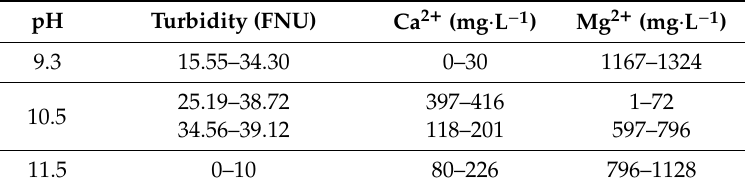
Table 8. Optimal concentration ranges of Ca 2 + and Mg 2 for the lowest residual turbidity (T) as a function of